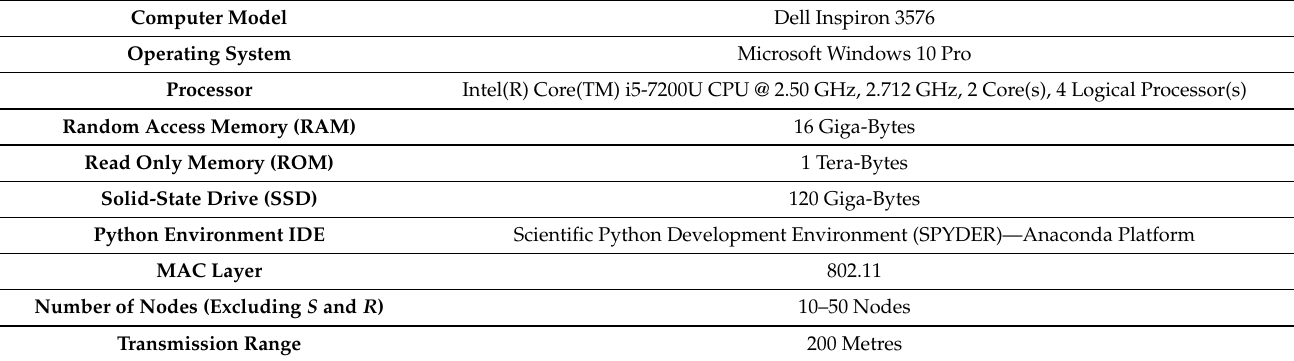
Table 2. Simulation